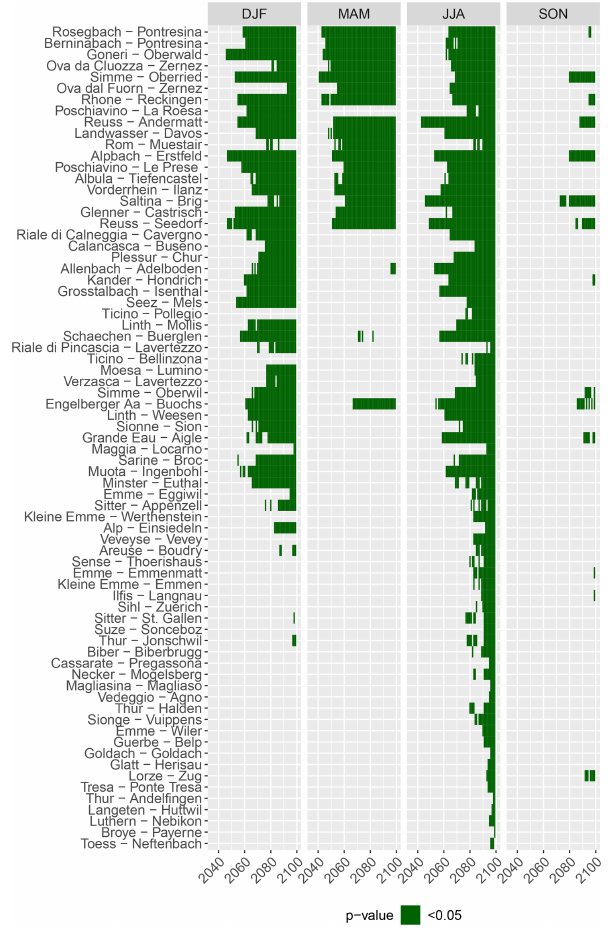
Figure 7. Temporal evolution of time of emergence for the seasons. Periods where the p value of the Kolmogorov–Smirnov test is lower than 0.05 are highlighted. Only catchments with at least one detec- tion of time of emergence in one of the seasons are shown. Catch- ments are ordered by decreasing mean elevation of